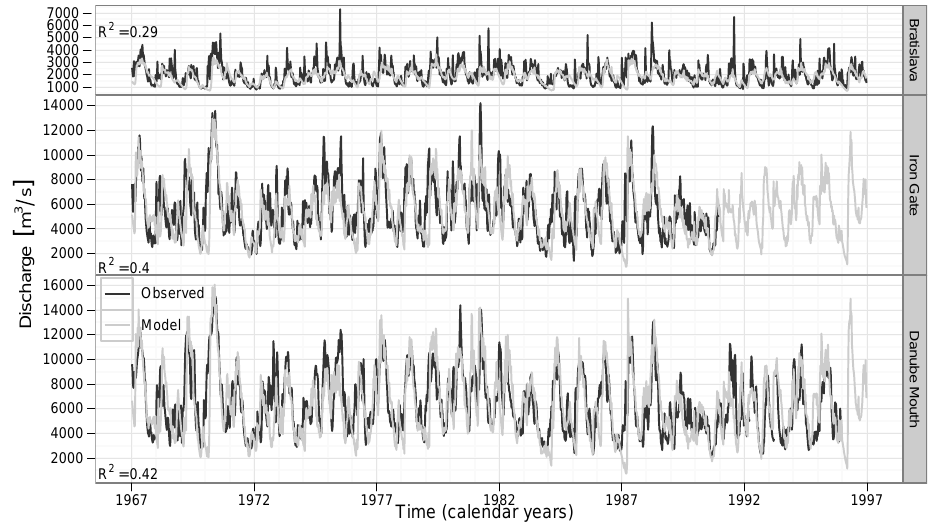
Fig. 4. Example hydrographs resulting from calibration. See Fig. 1 for the location of gauging stations Bratislava, Iron Gate and Danube Mouth (Ceatal